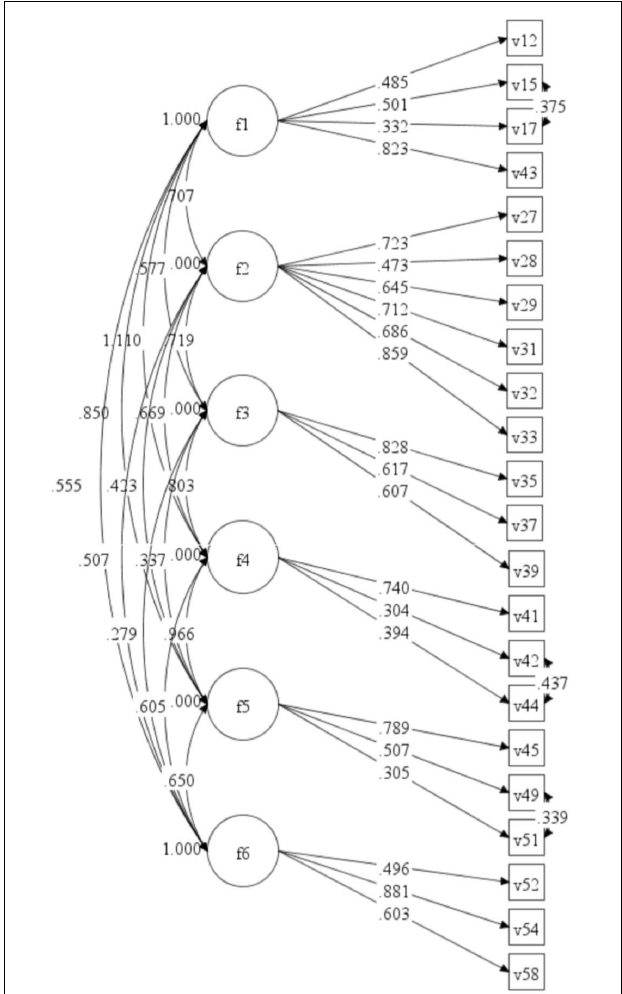
FIGURE 1 | The six-factor model and its standardized factor loading.